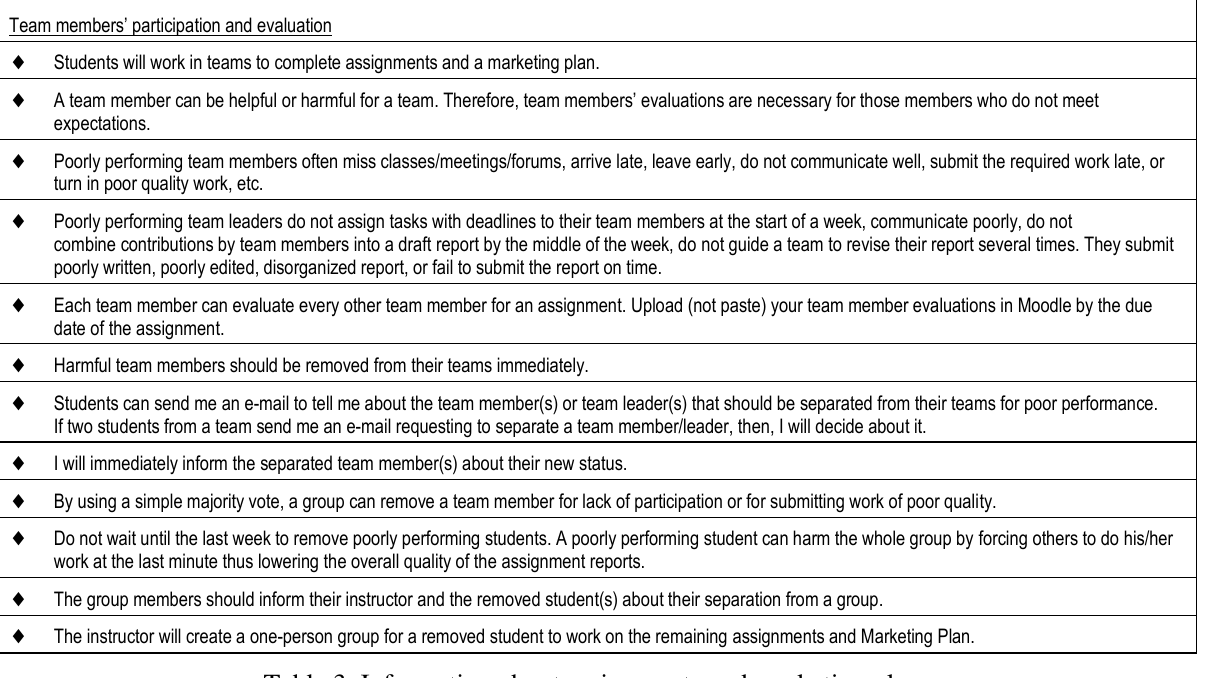
Table 3. Information about assignments and marketing